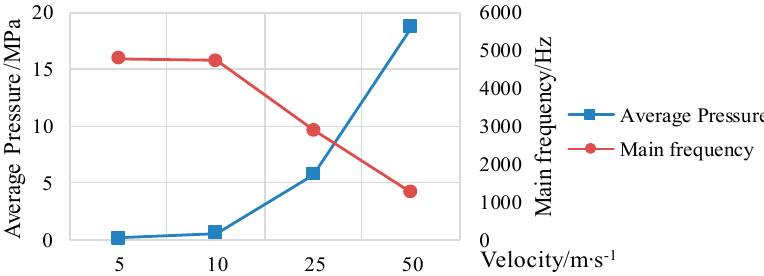
Figure 11. Pressure oscillation and main frequency of the flappers at different velocities.